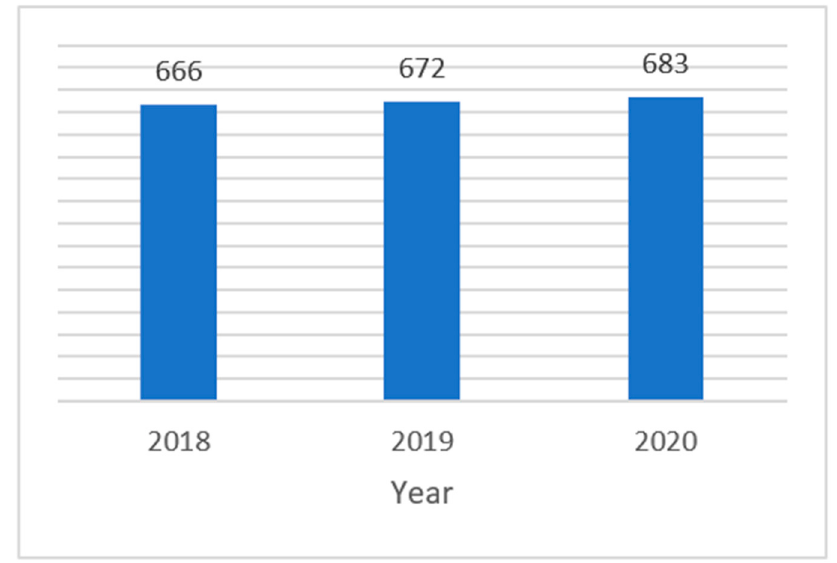
Figure 1. Number of CTs authorized per year at the CTO from 2018 to 2020.